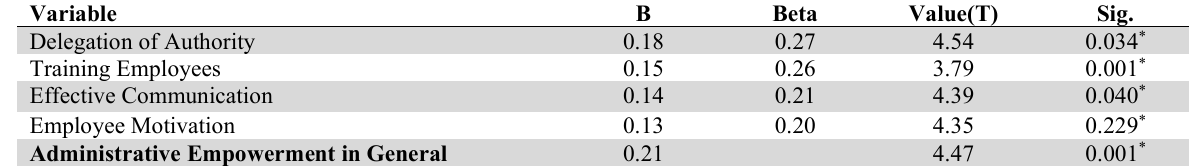
Results of the strength factor of the dimensions of administrative empowerment in enhancing the skills of the staff in solving problems and decision-making at Abu Dhabi